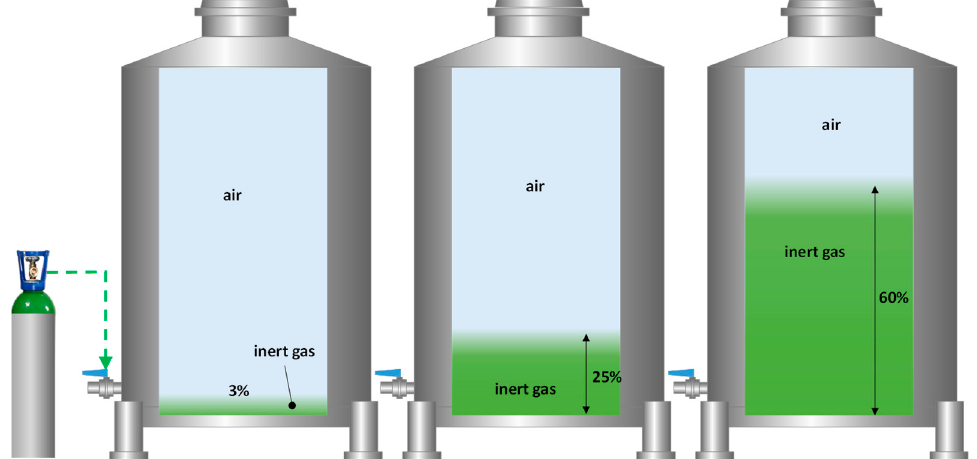
Figure 6. Diagram of the purging process with different inert gases and different thicknesses of the applied gas cover. A total of 3% corresponds to a thickness of 0.04 m of each gas; 25% to a thickness of 0.4 m; and 60% to 1 m.